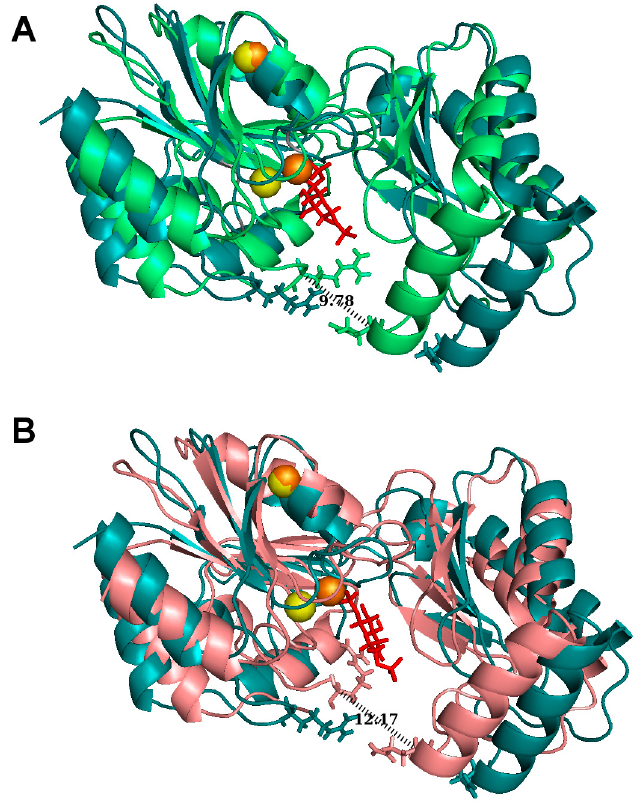
Figure 2. In silico binding models for PMM2 and β G16P: either the phosphate proximal to C6, P6_Mg mode ( A ), or the phosphate proximal to C1, P1_Mg mode ( B ), can interact with the catalytic site. PMM2 in the initial state is in cyan ( A , B ); the two closed conformations are in green ( A ) and pink ( B ); β G16P is red; Mg 2+ are shown as spheres.